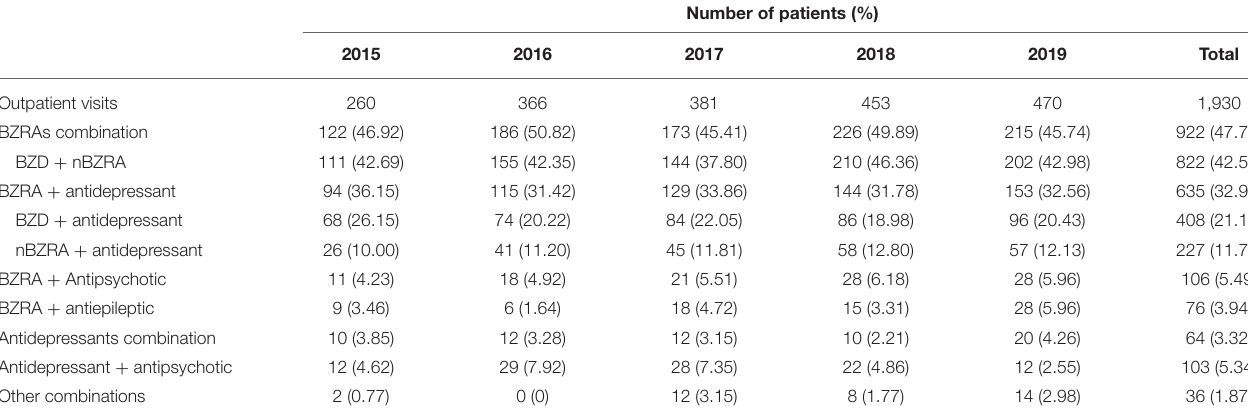
TABLE 7 | Trends of double medication combinations prescribed in sampled outpatients with insomnia between 2015 and